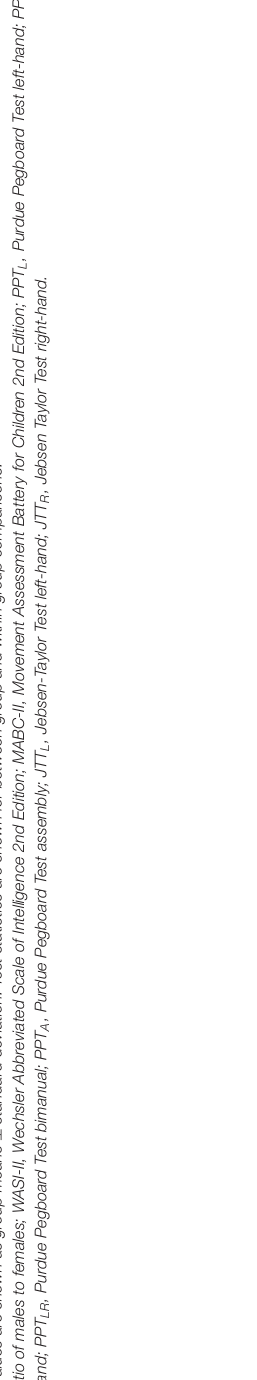
TABLE 2 | Distribution of co-occurring attention, learning and anxiety disorders by participant and group. Participant (DCD) Attention Active tDCS